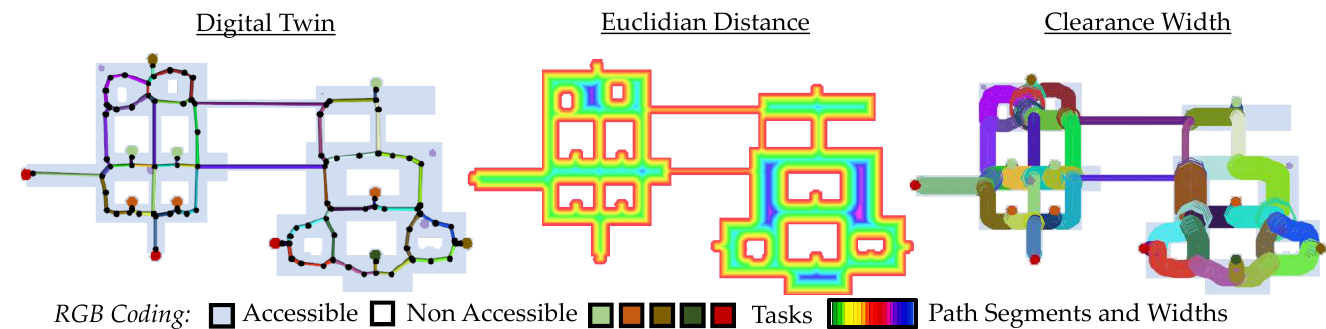
Figure 18. Digital twin for the extended map: graph generation, Euclidean distance, clearance width.